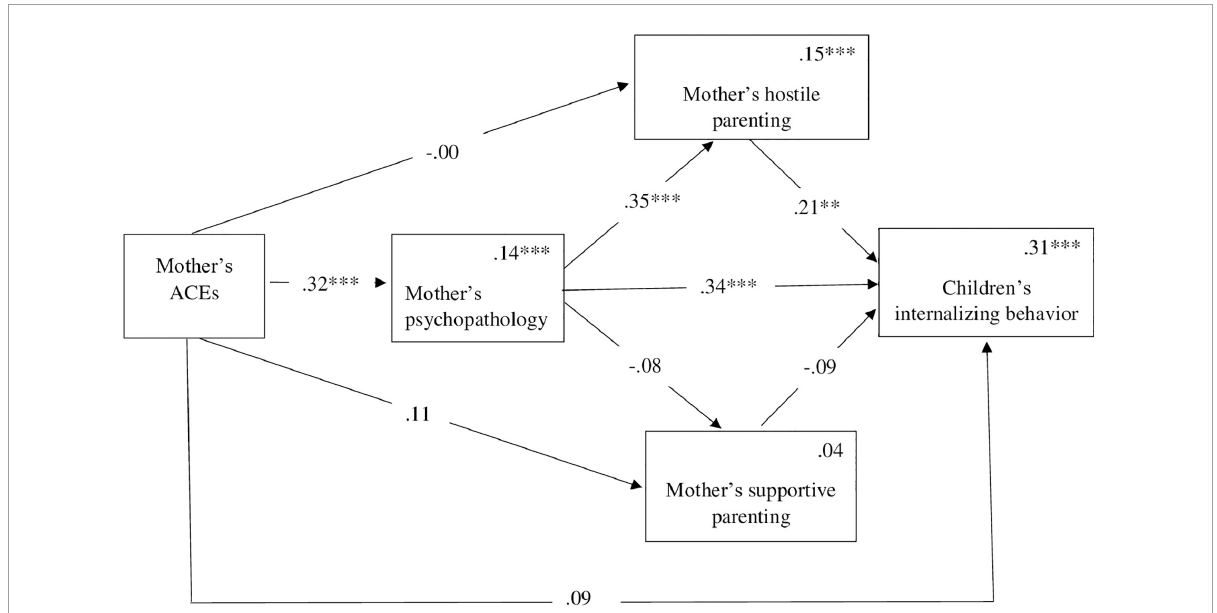
FIGURE2 Mediation model for the association between the mother’s ACEs internalizing behavior via the mother’s psychopathology and her hostile or supportive parenting. Numbers above the lines are standardized coefficients. Numbers in the upper right-hand corner in the rectangles present R 2 . While not presented in the figure, the child’s age and gender were included as covariates in the model. ∗∗ p < 0.01, ∗∗∗ p < 0.001.